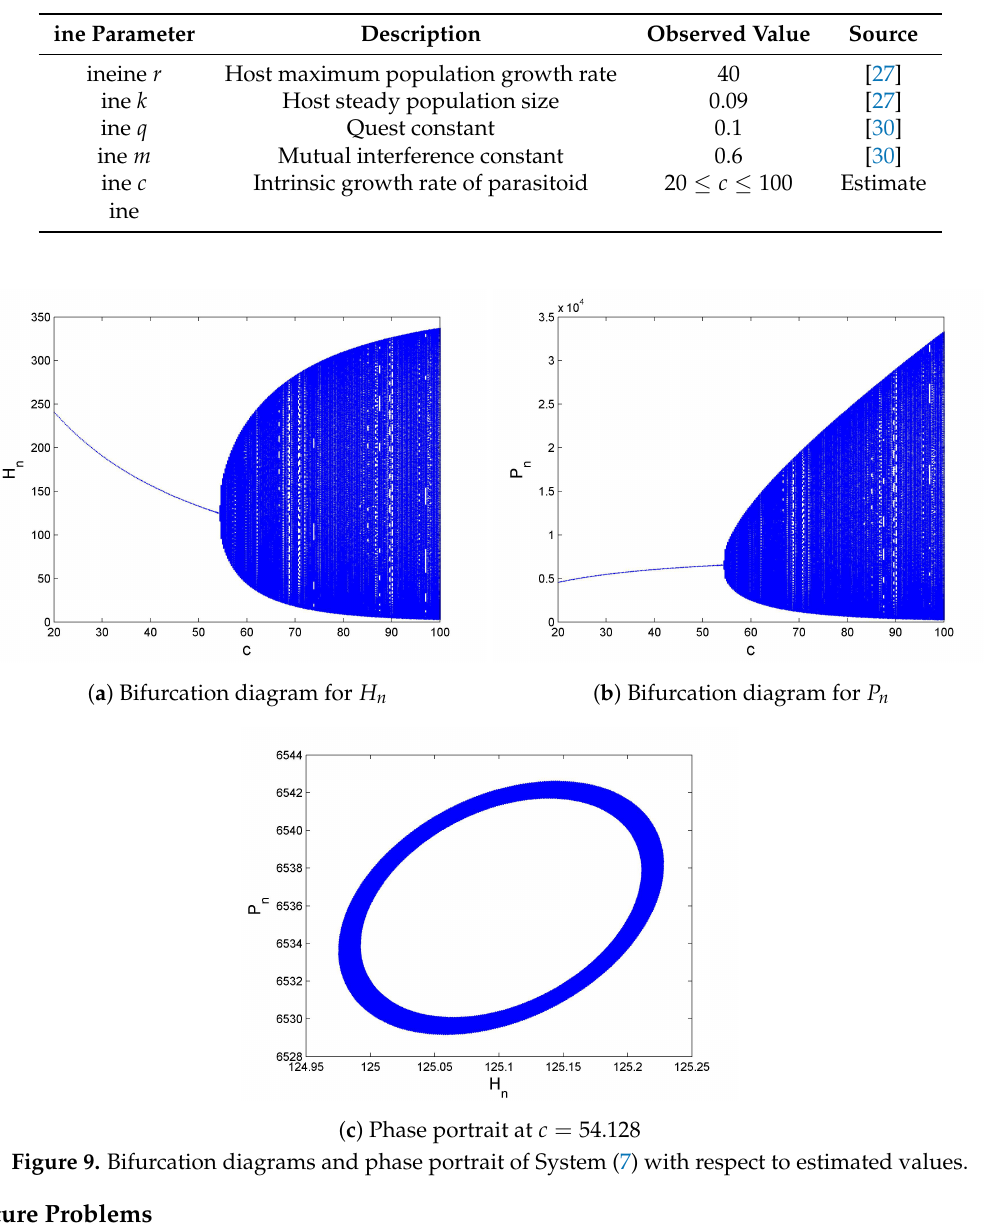
Table 1. Estimation for values of the parameters.